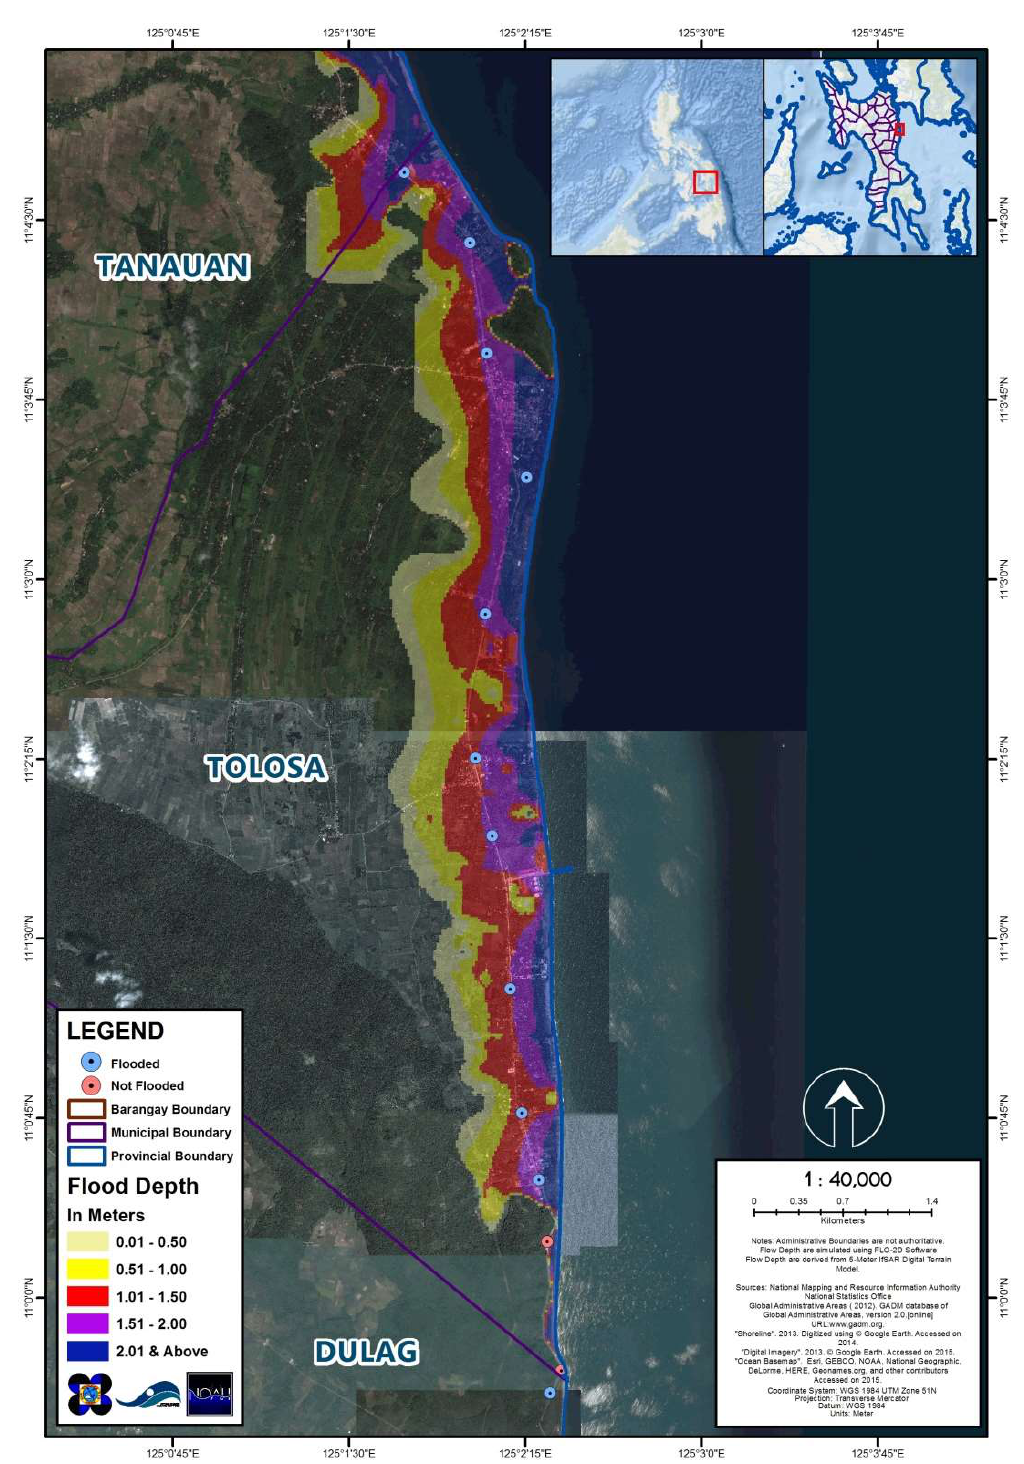
Figure 4. Storm surge inundation and validation points of Tanauan and Tolosa, Leyte. Validation points: blue circle (observed flooding) and red circle (no flooding).